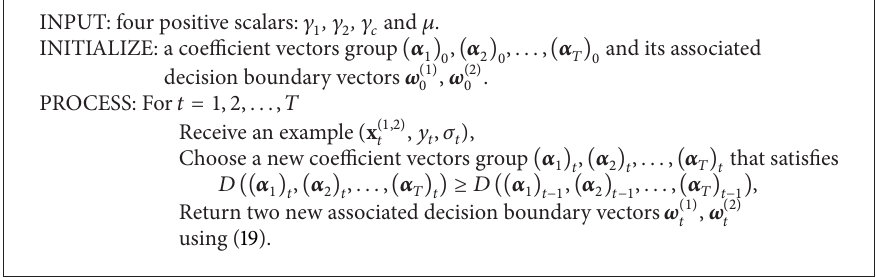
Algorithm 1: A template online co-regularization algorithm for multiview semi-supervised binary classification problems. This template algorithm aims for increasing the dual function on each learning